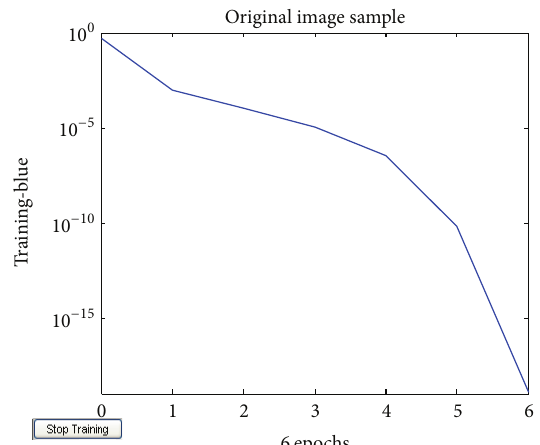
Figure 3: Training error plot for neural system developed.